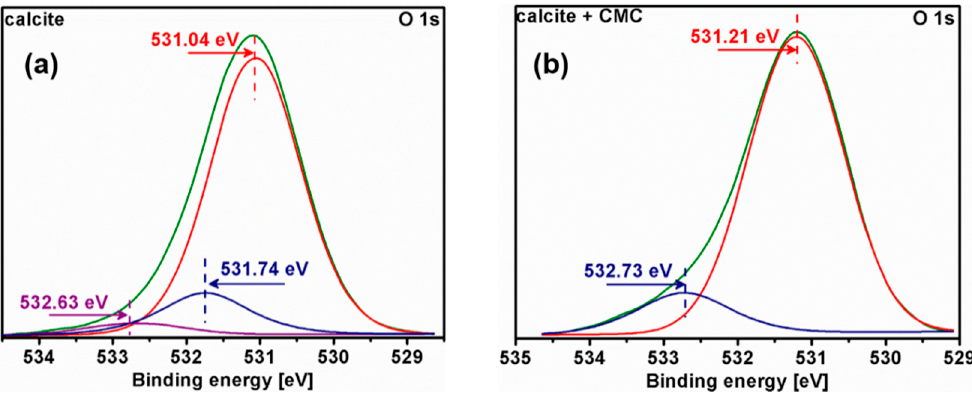
Figure 13. O 1s XPS spectra recorded from the surfaces of calcite in the absence ( a ) and presence ( b ) of CMC.